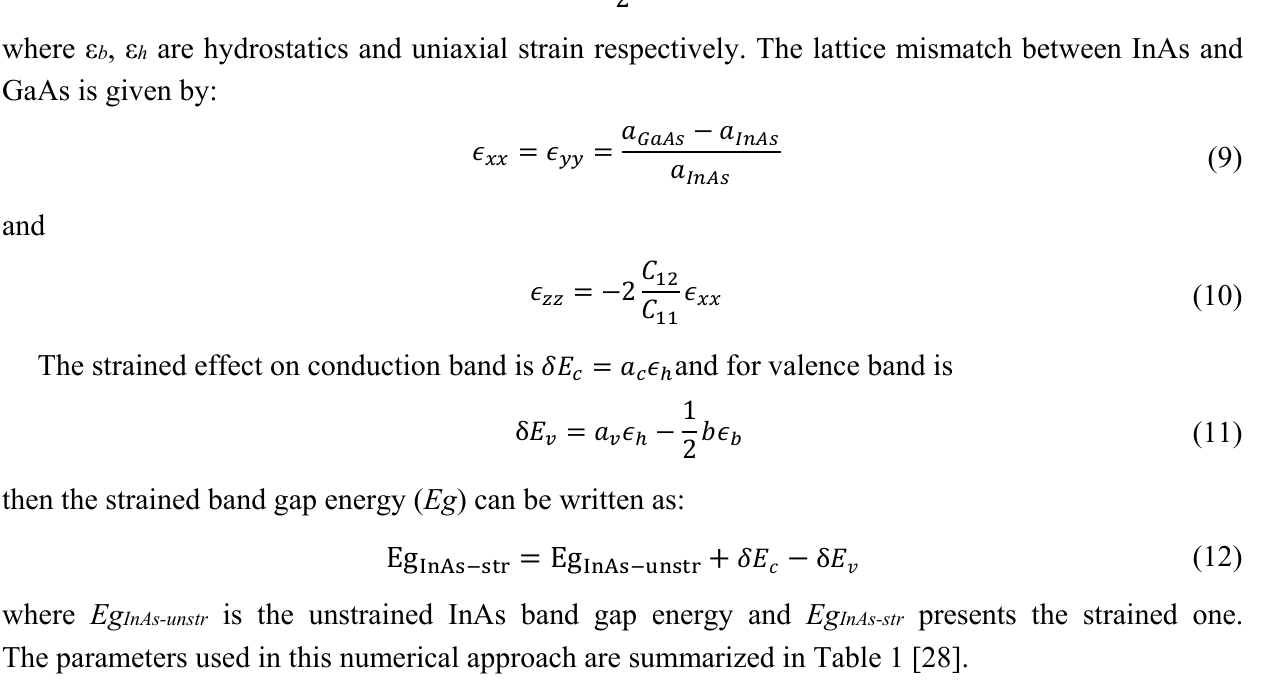
Table 1. InAs and GaAs parameters used for the